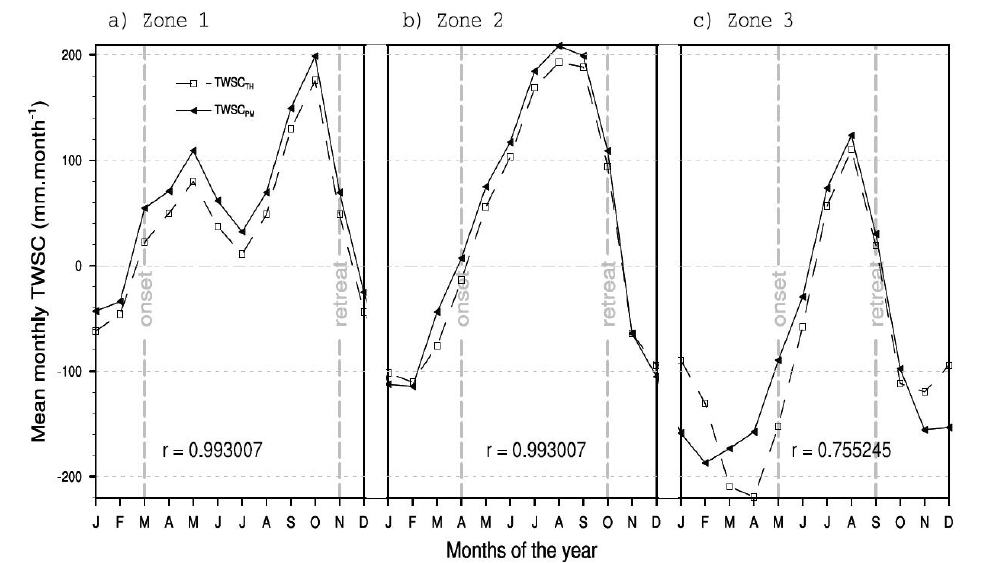
Figure 4. Annual cycles of mean monthly TWSC TH and TWSC PM (expressed in mm · month − 1 ) for the period 1962–1993: ( a ) for the Equatorial forest zone named Zone 1 (south of study area); ( b ) for the transition zone between the Equatorial forest zone and the Sahel zone named Zone 2; and ( c ) for the Sahelian zone named Zone 3 (north of study area). For each zone, there are two gray vertical dashed lines representing the mean onset and retreat month of the rainy season [30]. These months are absolutes and correspond to those containing onset and retreat dates in terms of pentads and their variabilities (not more than six pentads for the highest range). The labels on the x-axis (J, F, ..., D) indicate the months of the year (January, February, ..., December) respectively. r indicates the Spearman rank order correlation coefficient between TWSC TH and TWSC PM . Table 2. Errors on the estimated onset and retreat month of the rainy season using the TWSC